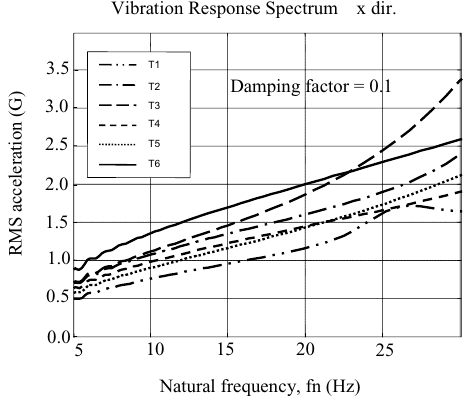
Fig. 8. Predicted RMS acceleration response of the HDD (x-direction).